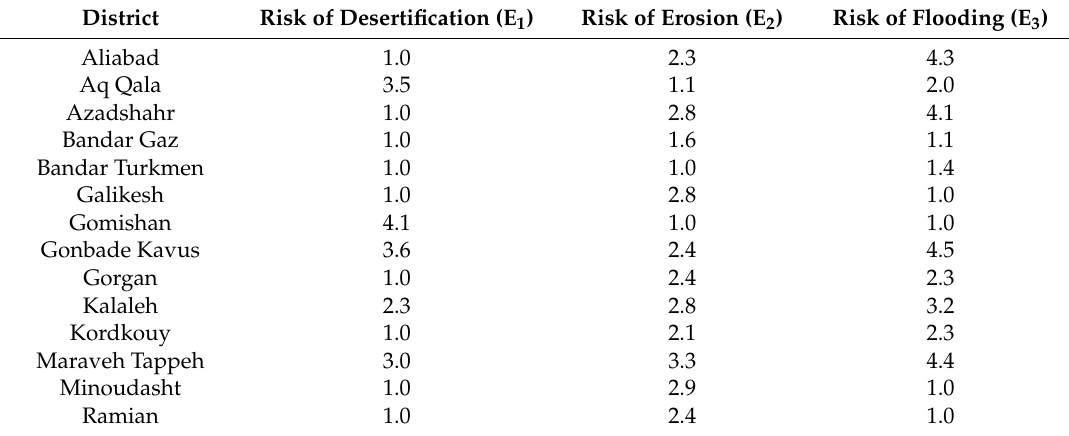
Table 7. The status of the “Environment” component in different districts of Golestan